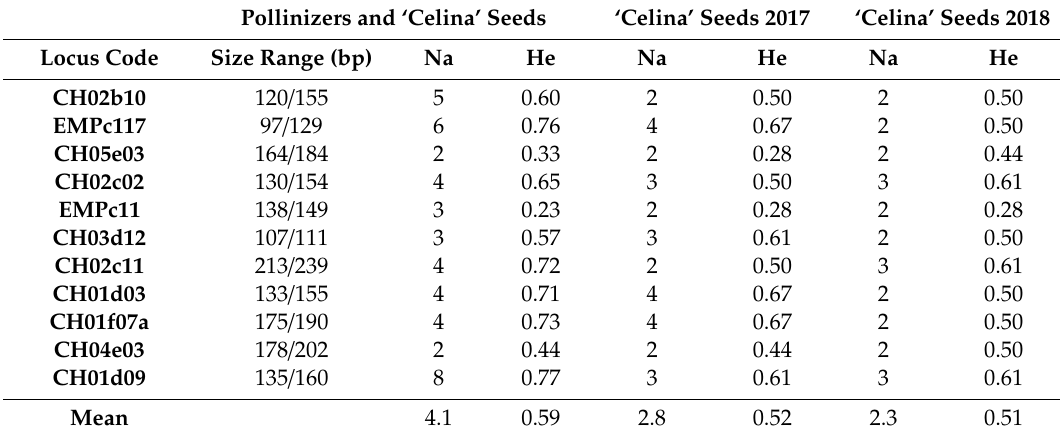
Table4. Allelesizerange(bp), numberofallelesperlocus(Na), andgenediversity(He)[38]forpollinizer cultivars (‘Fritjof’, ‘Anna’, ‘Clara Frijs’, ‘Herzogin Elsa’, and ‘Kristina’) and the main commercial cultivar (‘Celina’), as well as for ‘Celina’ seeds, collected in 2017 and 2018, based on 11 SSR loci. Pollinizers and ‘Celina’ Seeds ‘Celina’ Seeds